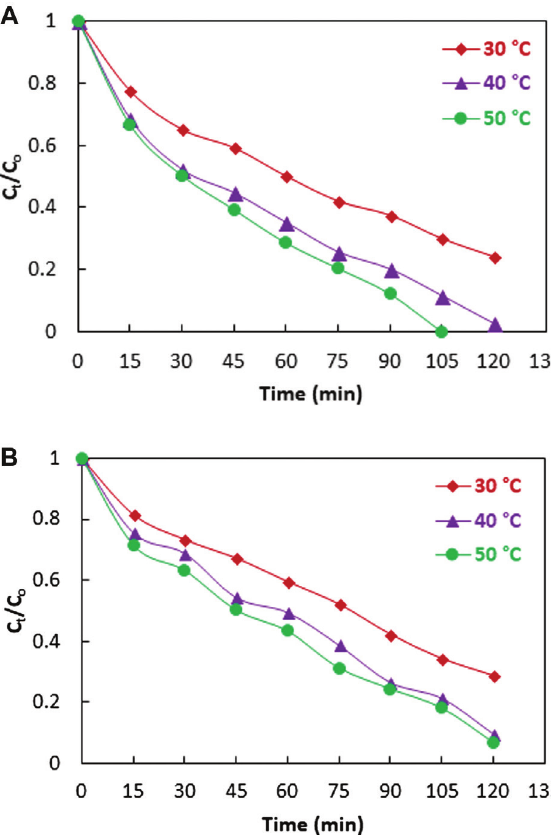
catalyzed photo degradation of (a) Methylene Figure 5: Ag-TiO 2 blue dye and (b) Rhodamine B dye, both at various temperatures.